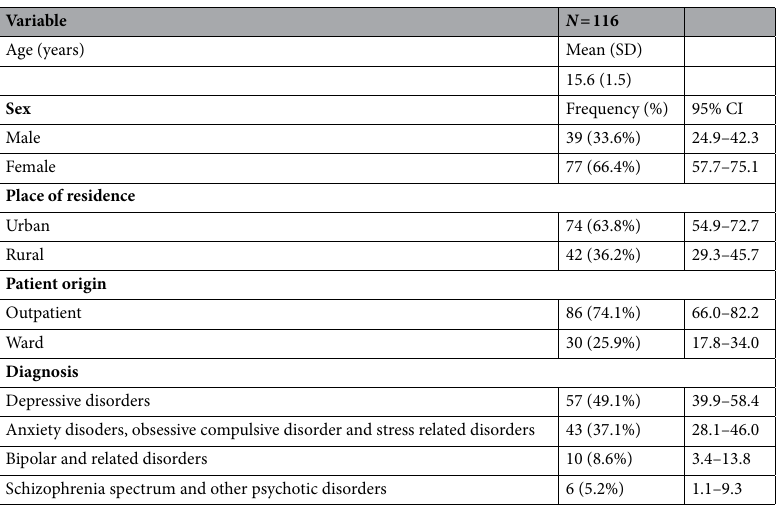
Table 2. Demographic characteristics. N, number; SD, standarddeviation; CI, confidence interval.